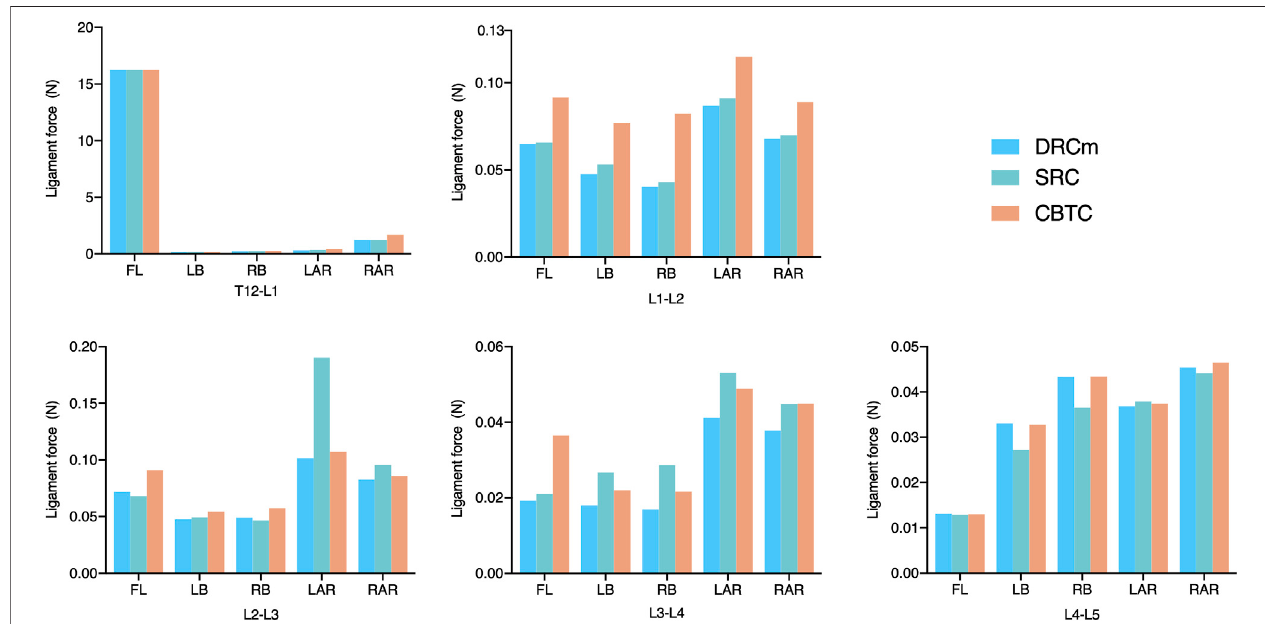
FIGURE 6 | Ligament force of the ISL in the loading direction of FL, LB, RB, LAR, and RAR after RS instrumentation using the DRCm, SRC, and CBTC.